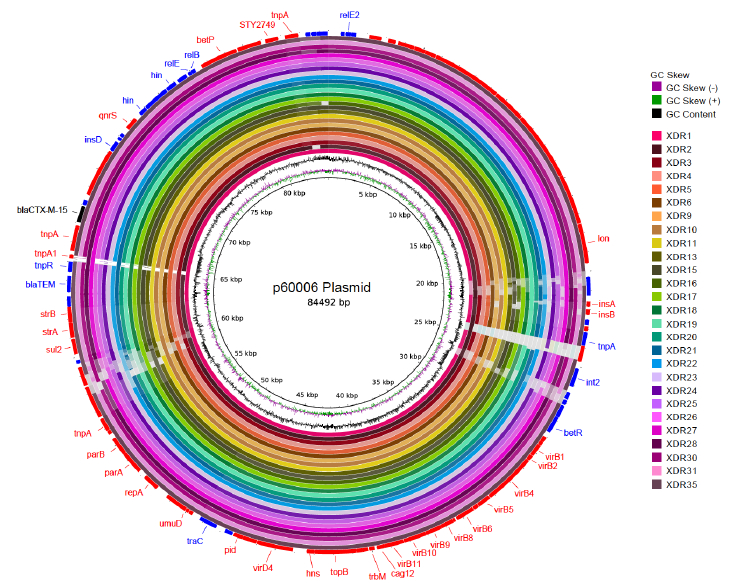
Figure 2. CTX-M-15 located on the IncY plasmid. The inner circle represents the reference plasmid sequence p60006. Concentric rings indicate BLAST identity between reference and strains sequenced as part of this study. BLASTn matches between 90% and 100% nucleotide identity are colored from lightest to darkest shade, respectively. Matches with less than 80% identity, or plasmid regions with no BLAST matches, appear as blank spaces in each ring. Inner most rings plot GC Skew and GC content. Outermost ring shows locations of coding sequences (red—sense; blue—antisense) and gene names are labeled where known. The CTX-M-15 gene is labeled in black.